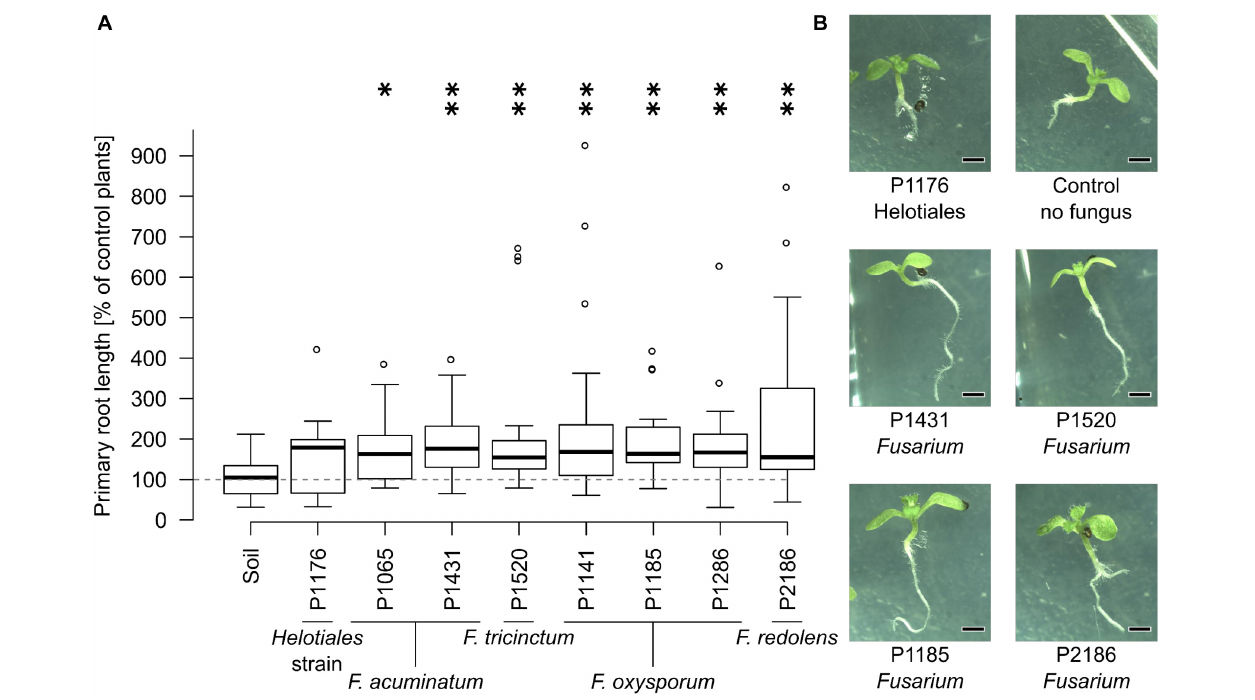
FIGURE 3 | The presence of Fusarium increases Arabidopsis primary root length. Bioassays were conducted as described in Figure 1 . (A) All soil-grown Fusarium strains but not the Helotiales one significantly increased primary root length compared to control seedlings (exposed to soil VOCs only) (Kruskal-Wallis test, ∗ indicates a p -value of ≤ 0.05, ∗∗ ≤ 0.01, n = 14 to 20 seedlings pooled from 3 to 5 Petri dishes). (B) Representative 11 days old seedlings grown with or without fungi (scale bar = 1